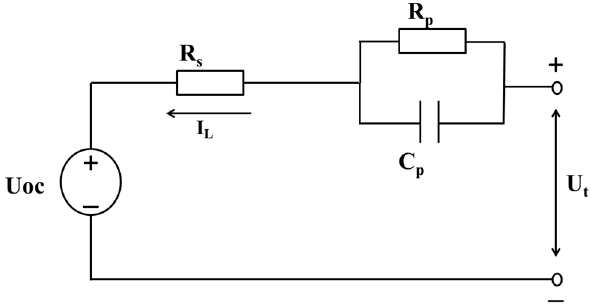
Figure 1. Schematic diagram of the first-order battery